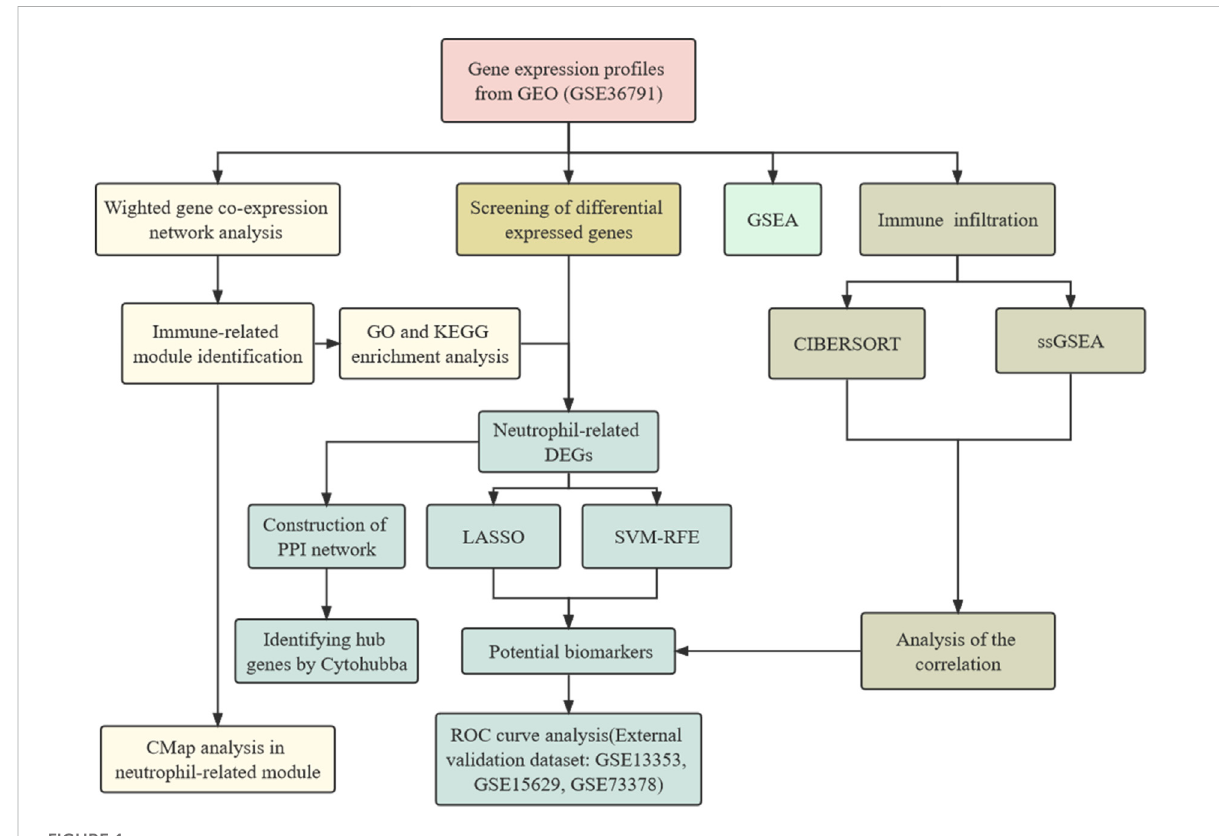
FIGURE 1 Study fl ow